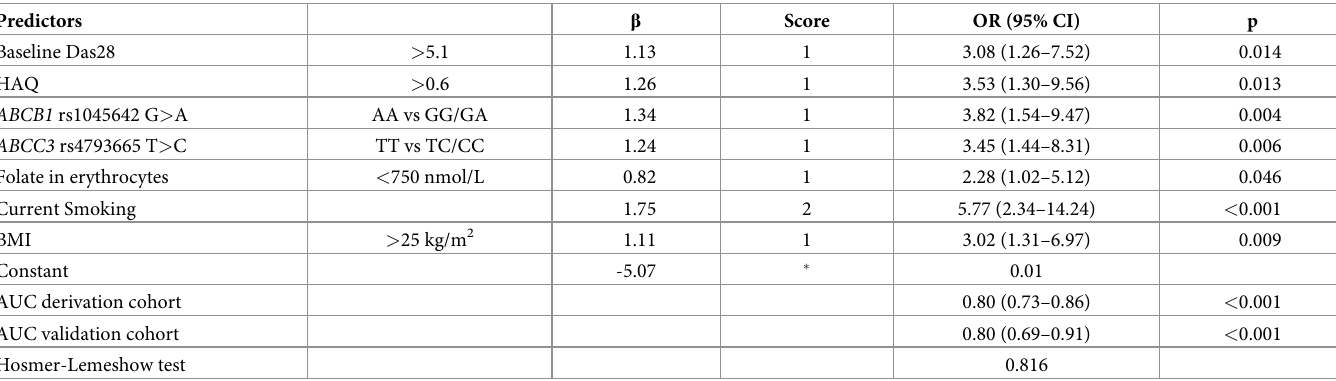
Table 3. Prediction model and scores for 3 months MTX non-response (DAS28 >